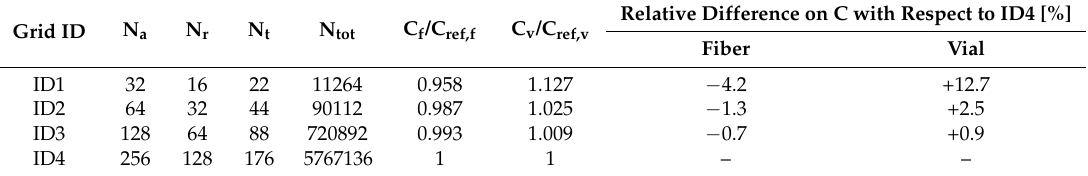
Table 2. Details of the grids used for mesh sensitivity analysis.